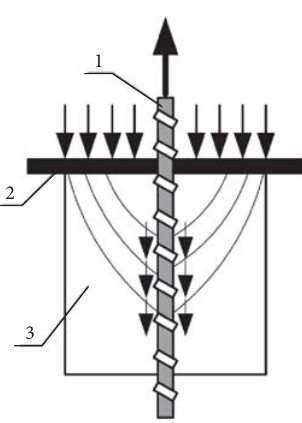
Fig. 3. Scheme of beam bending test: 1 – concrete